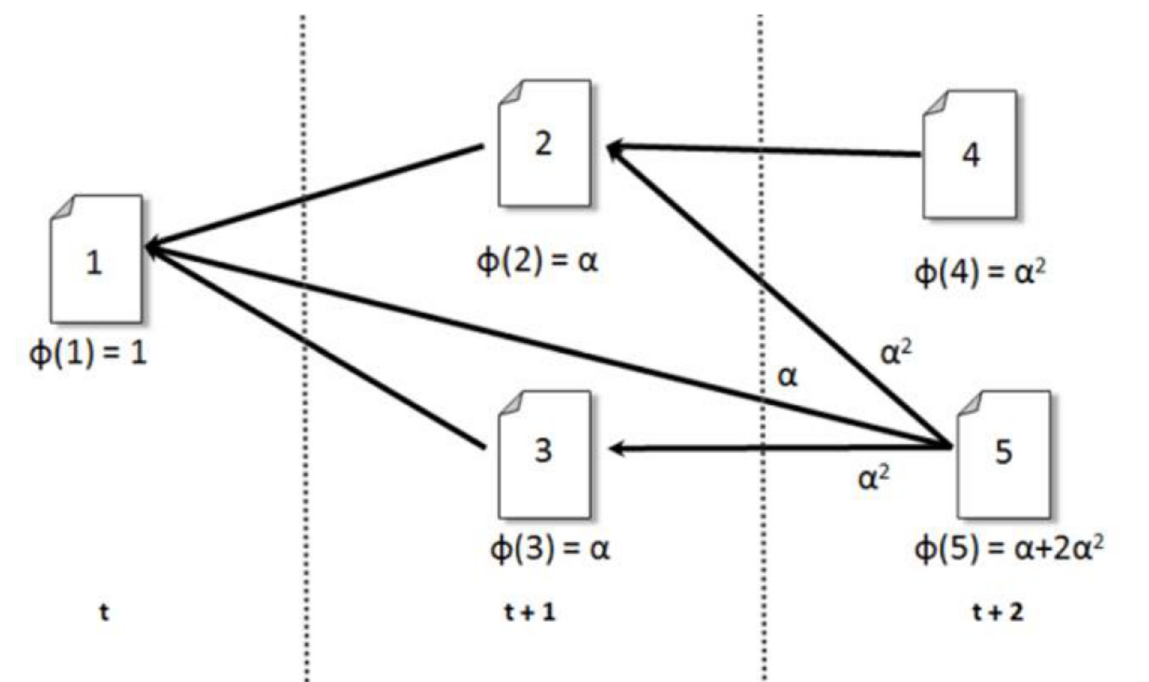
Fig 1. An example of cascade and ϕ values in a citation